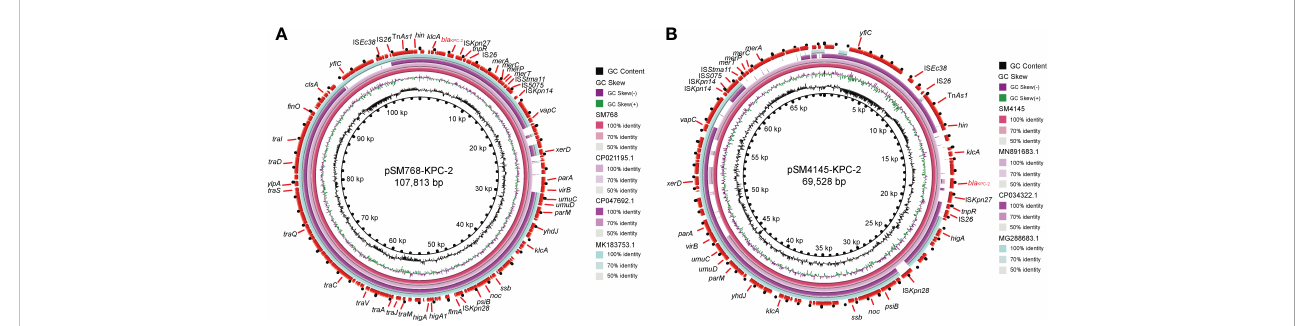
FIGURE 2 Complete sequences of two bla KPC-2 - harbouring IncR plasmids were recovered in this work. (A) Alignment of plasmid sequence of pSM768-KPC-2 with other bla KPC-2 - bearing plasmids pH17-2 (CP021195), pC110-KPC (CP047692), and p17-15-KPC (MK183753). (B) Comparison of pSM4145-KPC-2 with plasmids pK033_1 (CP034322), p314013-KPC (MN891683), and pE20-NR (MG288683). Circles inside to outside denote the GC content, GC screw, and the ORFs in both DNA strands. Block arrows represent coding sequences and indicate the direction of transcription. bla KPC-2 gene is highlighted in red. Arrow size is proportional to gene length. The circular image of multiple plasmids comparisons was generated with the BLAST Ring Image